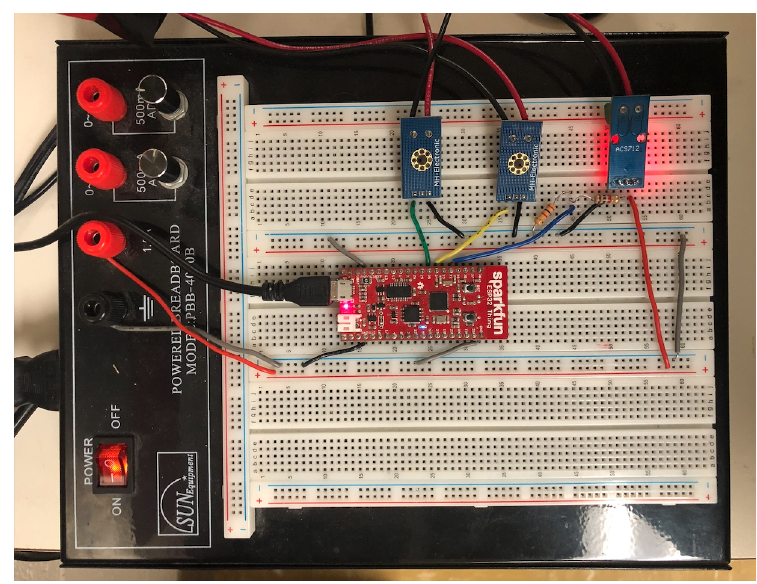
Figure 9. Hardware implementation of the proposed SCADA system.